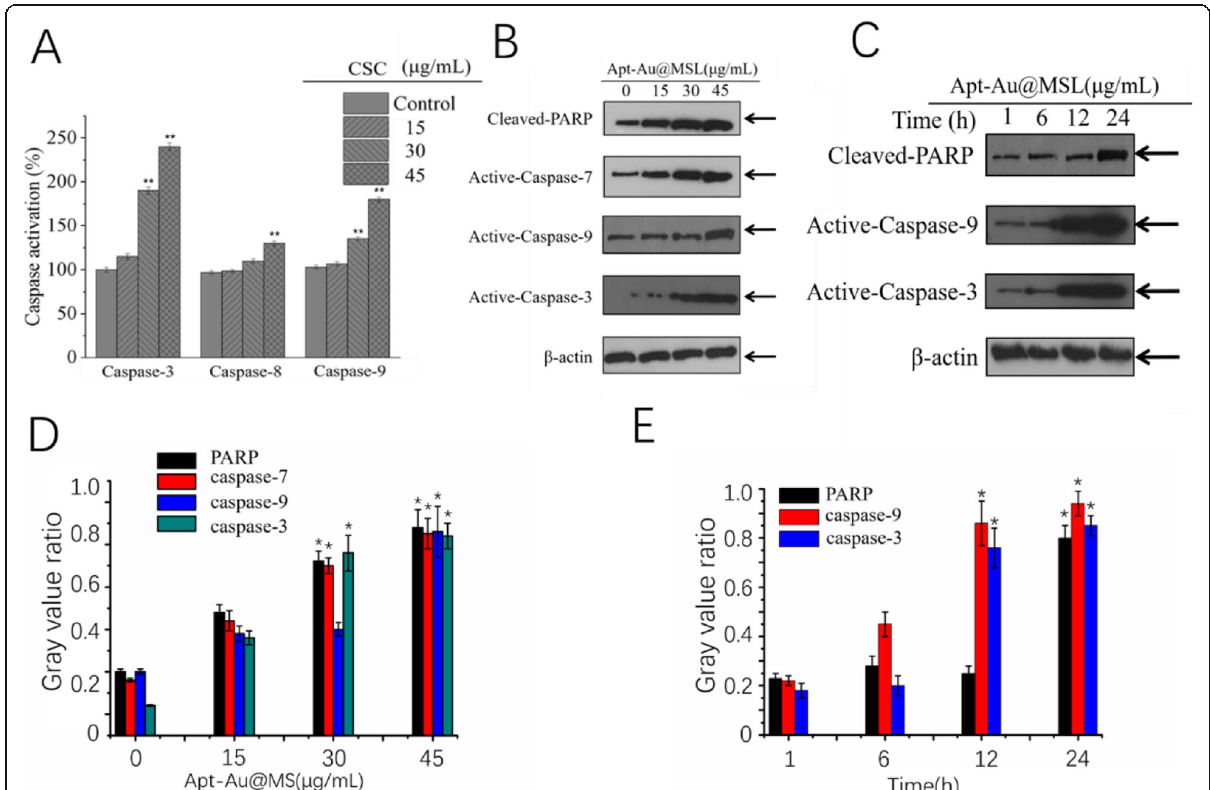
Fig. 8 Apt-Au@MSL induced apoptosis in SGC-7901 cells. a SGC-7901 cells were treated with indicated concentrations of Apt-Au@MSL for 24 h. Then, the total protein was extracted and incubated with synthetic Apt-Au@MSL substrates for measuring caspase activities. Dose-dependent ( b ) and time-dependent ( c ) effects of Apt-Au@MSL on PARP and caspases expression. d , e Quantitative analysis of PARP, caspase-7, caspase-9, and caspase-3 expressions. Data are means ± SD, * P < 0.05, ** P <